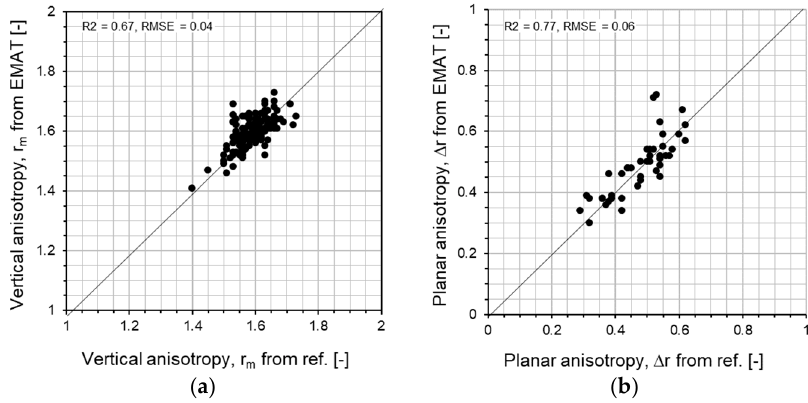
Figure 6. Results of the calibration to deep-drawing parameters based on measuring parameters from electromagnetic acoustic transducer (EMAT) measurements; nondestructively predicted values (from EMAT) are shown as a function of destructively measured values (from ref.): ( a ) for vertical anisotropy r m and ( b ) for the planar anisotropy ∆ r.